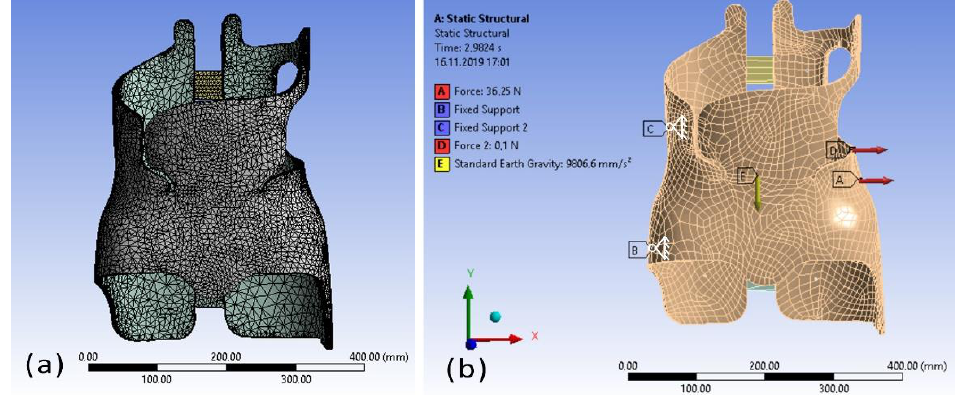
Figure 5. Numerical orthosis model: ( a ) tetrahedral FE mesh generated, ( b ) boundary conditions applied to the geometric model that has been imported; mathematical description (NURBS): A —pre-loading force corresponding to the action of the torso on the brace, B and C —fixed supports, D —additional force added after pre-loading of the orthosis, E —gravitational force.